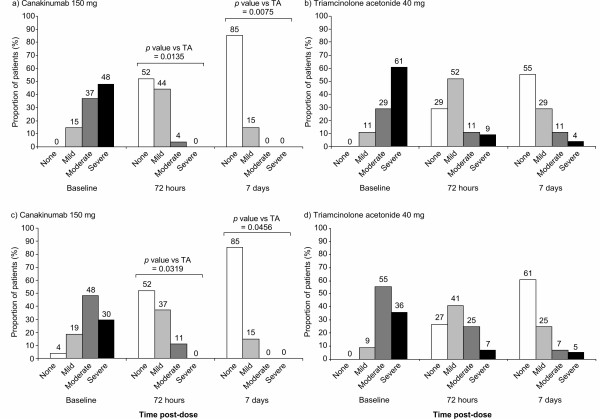
Reduction in joint inflammation following administration of study medication. Physician's assessment of joint tenderness in patients receiving canakinumab 150 mg (a) or triamcinolone acetonide (TA) 40 mg (b) and physician's assessment of joint swelling in patients receiving canakinumab 150 mg (c) or triamcinolone acetonide 40 mg (d). Physicians assessed inflammation in the target joint using the following tenderness and swelling scales: tenderness rated as none, 'no pain'; mild, 'pain'; moderate, 'pain and winces'; severe, 'pain; winces and withdraws'; and swelling rated as none, 'no swelling'; mild, 'palpable'; moderate, 'visible'; and severe, 'bulging beyond the joint margins'. Percentages are rounded to one unit therefore numbers at each time point do not necessarily add to 100. TA, triamcinolone acetonide.